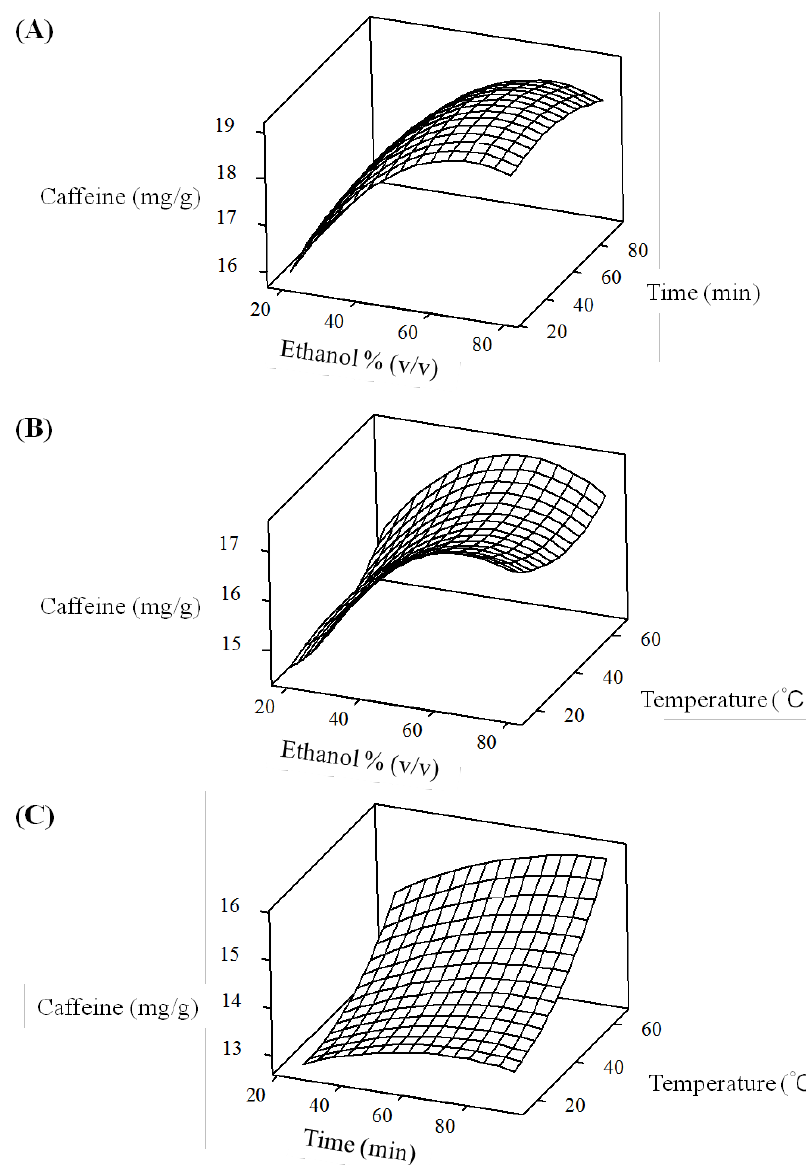
Figure 2. Response surface plots for the effects of ethanol concentration, extraction time and temperature on caffeine contents of green tea extracts. ( A ) Ethanol concentration and extraction time; ( B ) ethanol concentration and extraction temperature; and ( C ) extraction time and temperature.